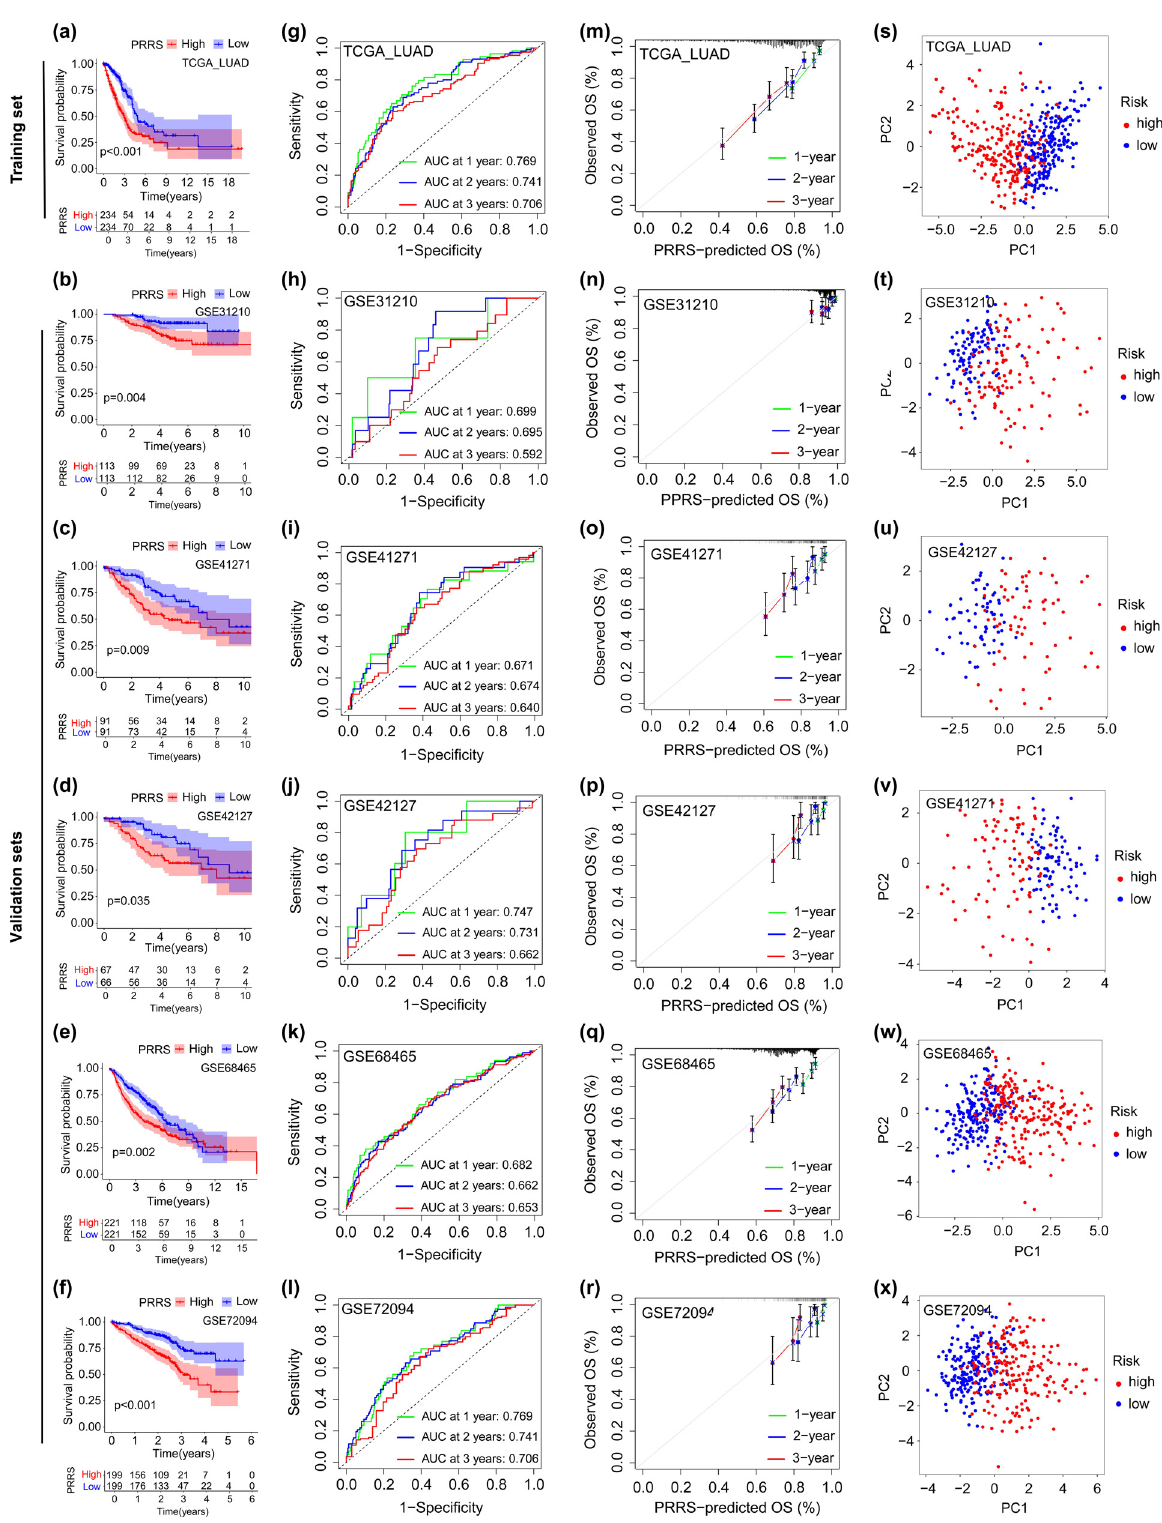
Figure 3: Evaluation of the e ff ectiveness of PRRS in the training and veri fi cation datasets. ( a – f ) KM survival curves of OS in training ( a ) and validation ( b – f ) datasets. ( g – l ) ROC curves evaluate the e ff ectiveness of PRRS in training ( g ) and validation ( h – l ) datasets. ( m – r ) Calibration curves for evaluating the accuracy of PRRS in training ( m ) and validation ( n – r ) datasets. ( s – x ) PCA results of patients from the training ( s ) and validation ( t – x ) datasets according to